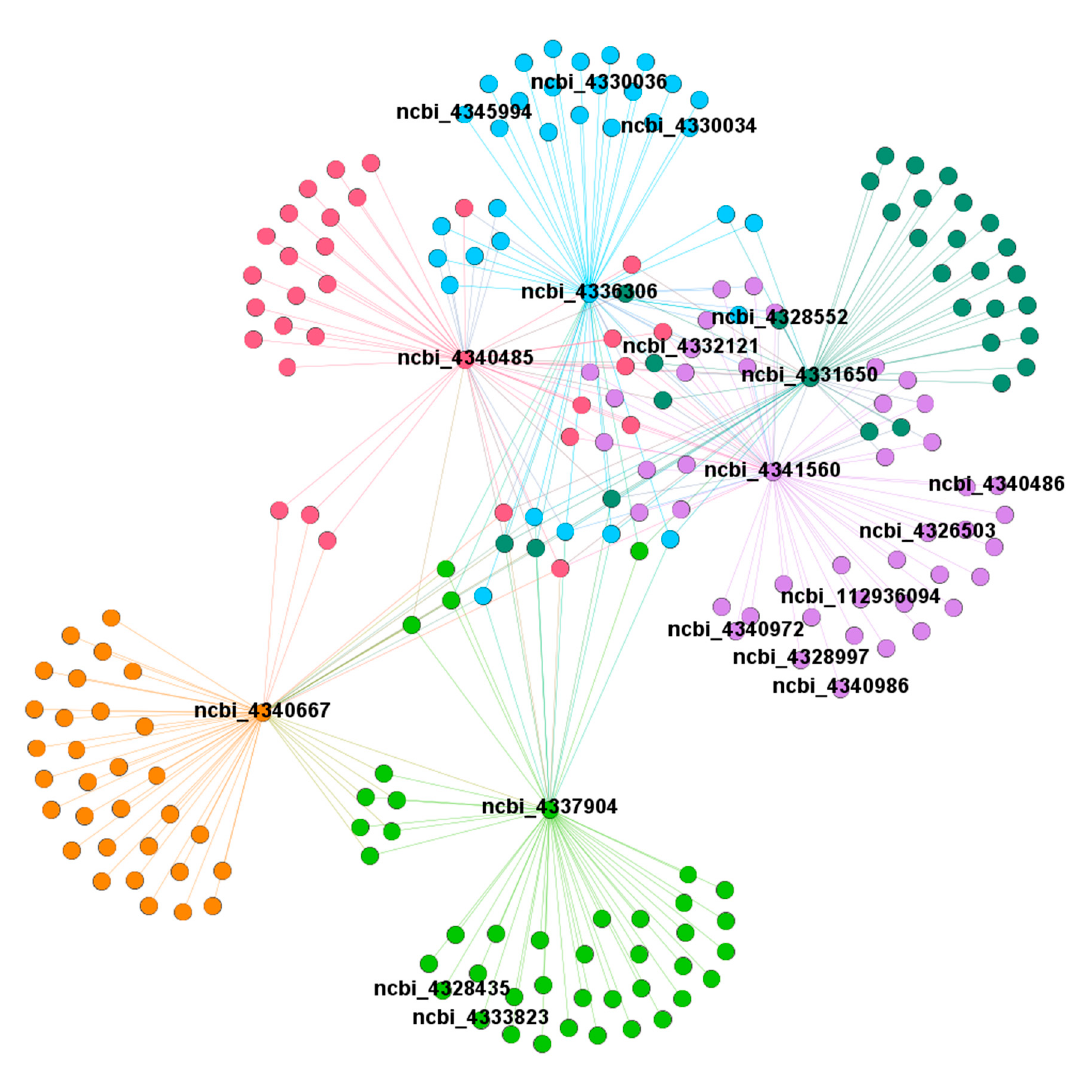
Figure 11. Co-expression regulatory network analysis of module turquoise.